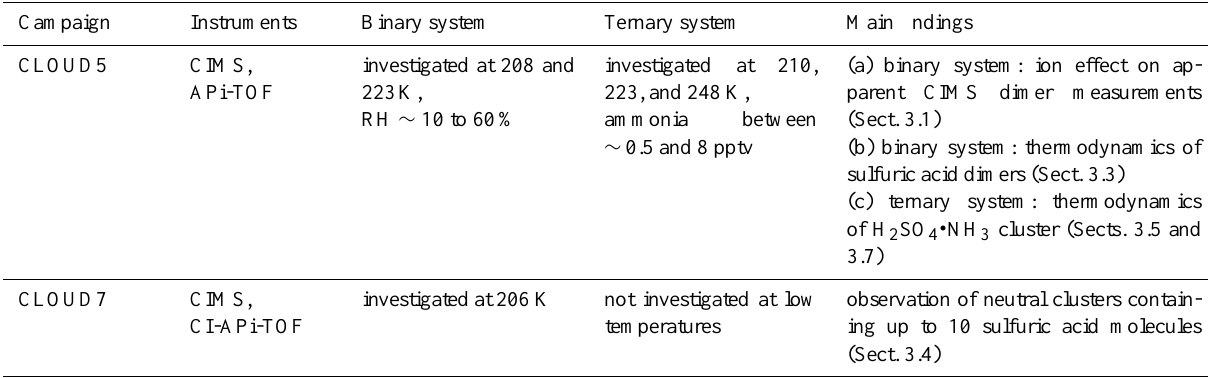
Table 1. Overview over the different conditions, instruments, and main findings relevant to this study from the CLOUD5 and CLOUD7